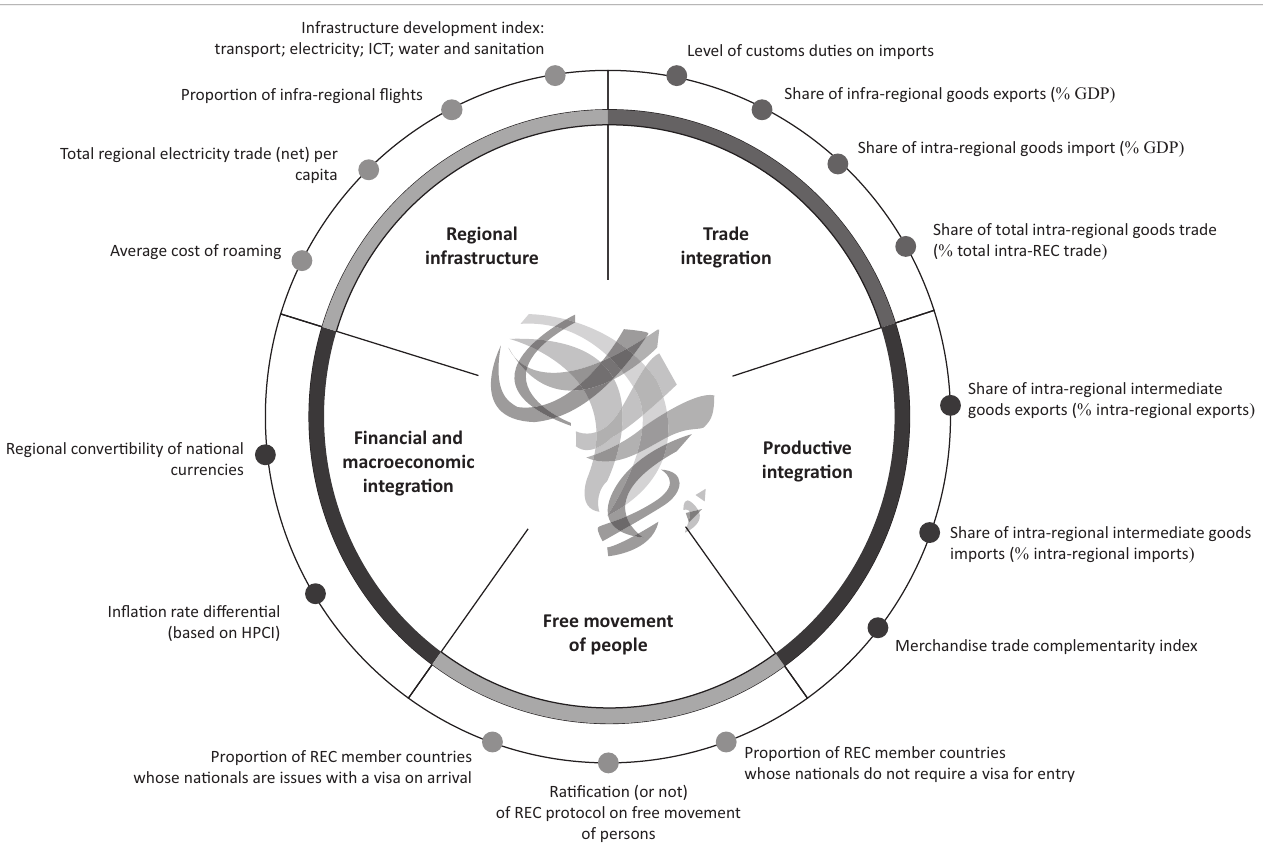
FIGURE 1: African regional integration index: The five